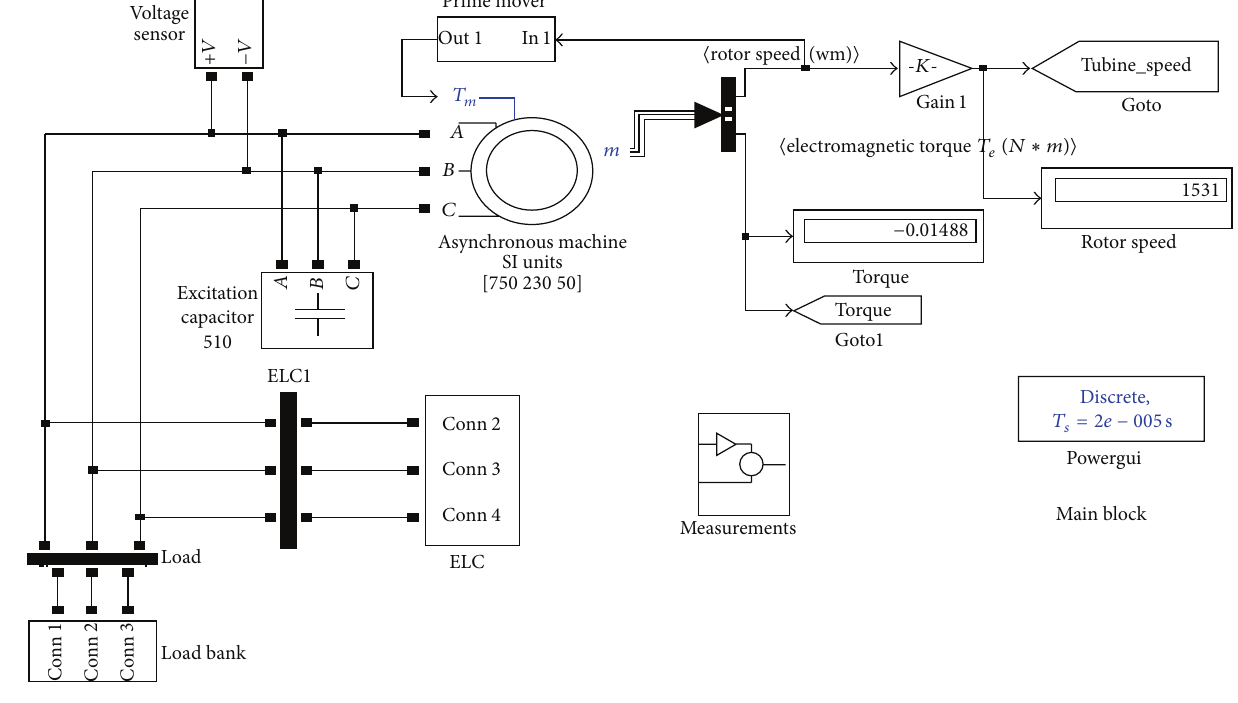
Figure 4: Main block of the proposed system.